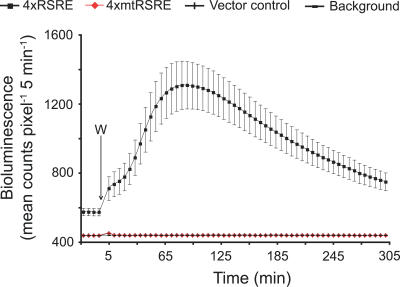
The RSRE Confers Wound-Induced Reporter Gene ExpressionIndependent T1 4xRSRE:LUC and 4xmtRSRE:LUC lines were mechanically wounded. Luciferase activity was then monitored in the wounded leaf. Data are means of n = 24 ± SEM.